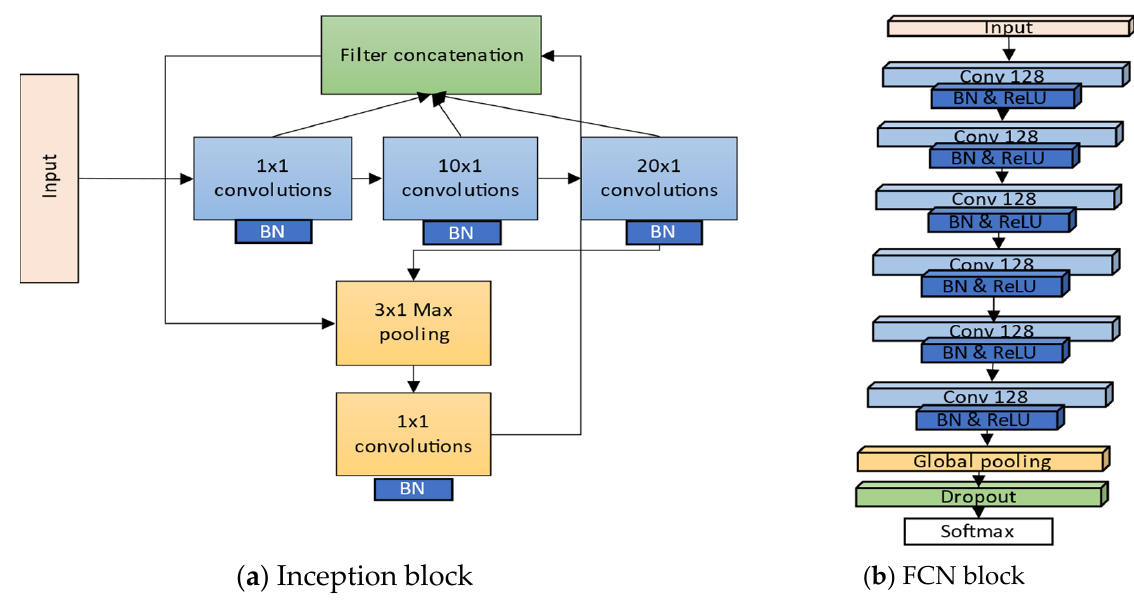
Figure 2. The overview of our Inception ( a ) and FCN ( b ) blocks.